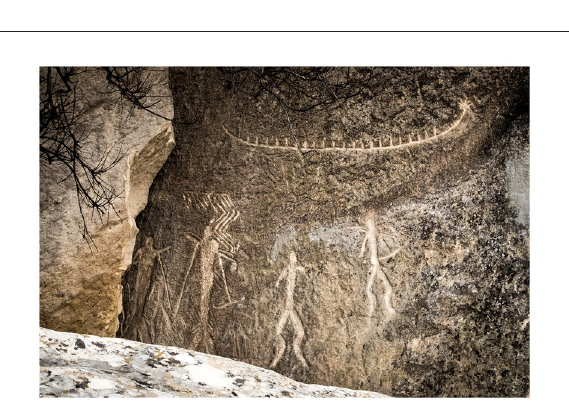
FIGURE2 Rock carving from Gobustan National Park near Baku,